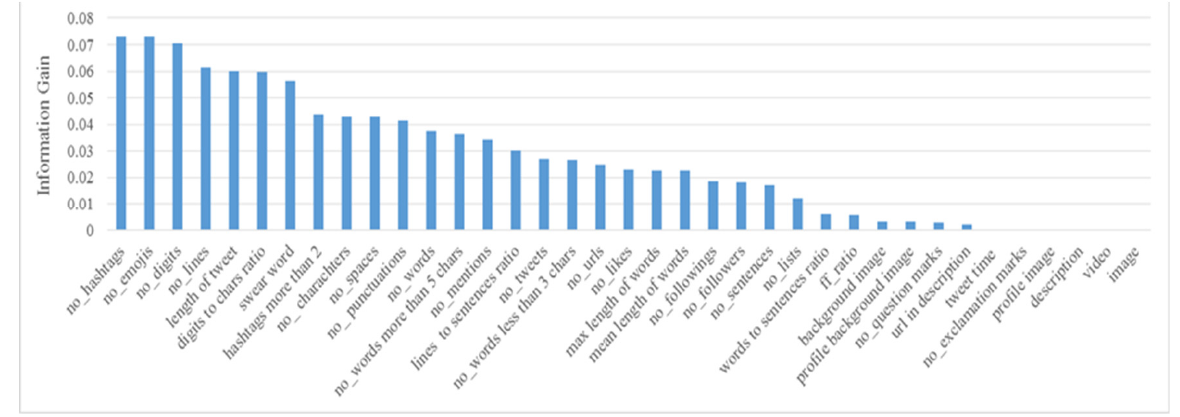
Figure 1. Values of information gain of each feature .